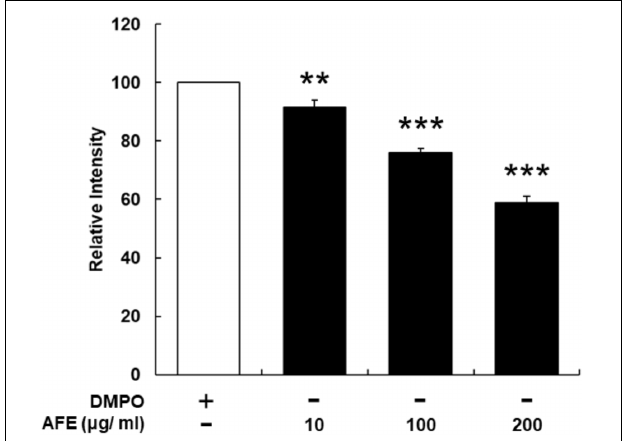
FIGURE 4 | Anoectochilus formosanus extract processes an ability of free radical scavenging. The AFE-induced free radical-scavenging assay was conducted as described in the Section “Materials and Methods.” The free radical scavenging ability was in a concentration-dependent manner. n = 3, ∗∗ p < 0.01, ∗∗∗ p < 0.001 as compared with control